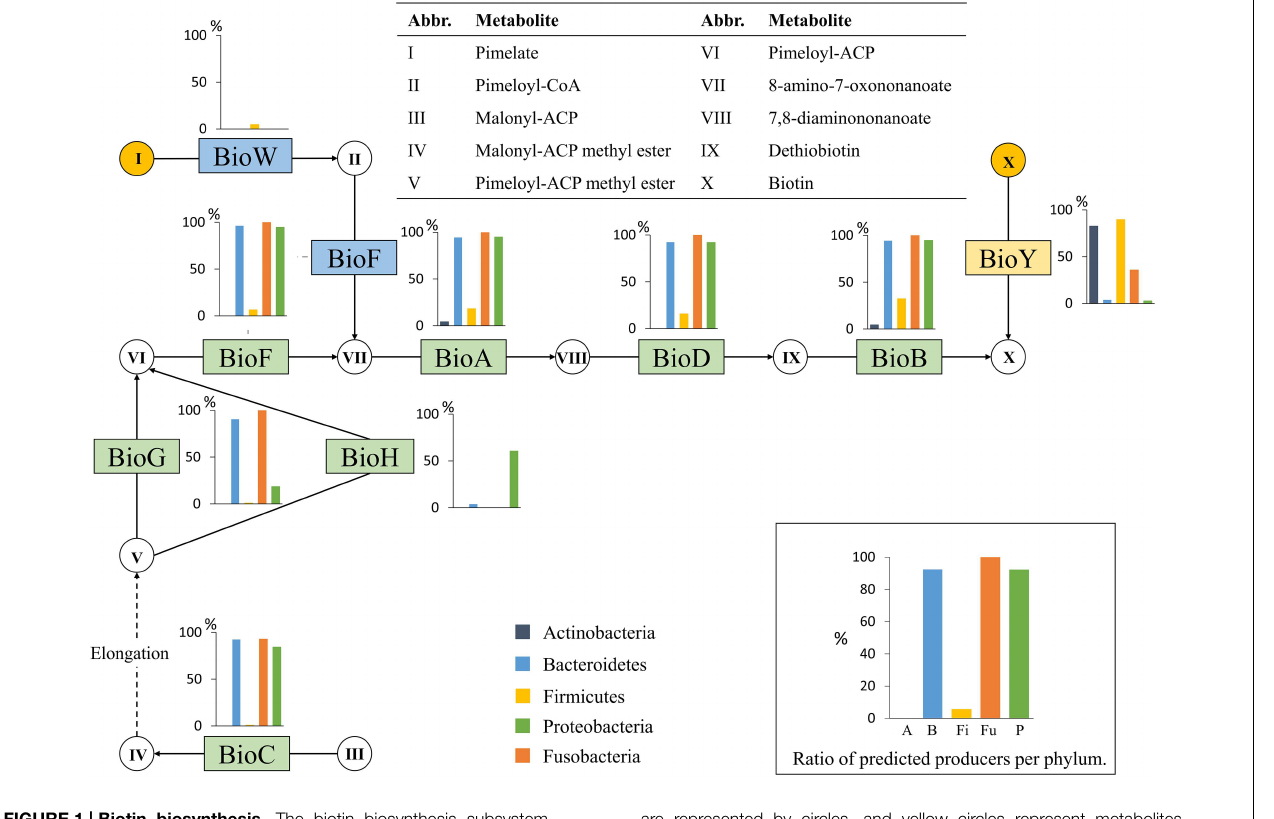
are represented by circles, and yellow circles represent metabolites that can be salvaged from the environment in some cases. Only the core metabolites of the biosynthesis pathway are listed. Each bar graph represents the percentage of organisms in each phylum that contain the functional